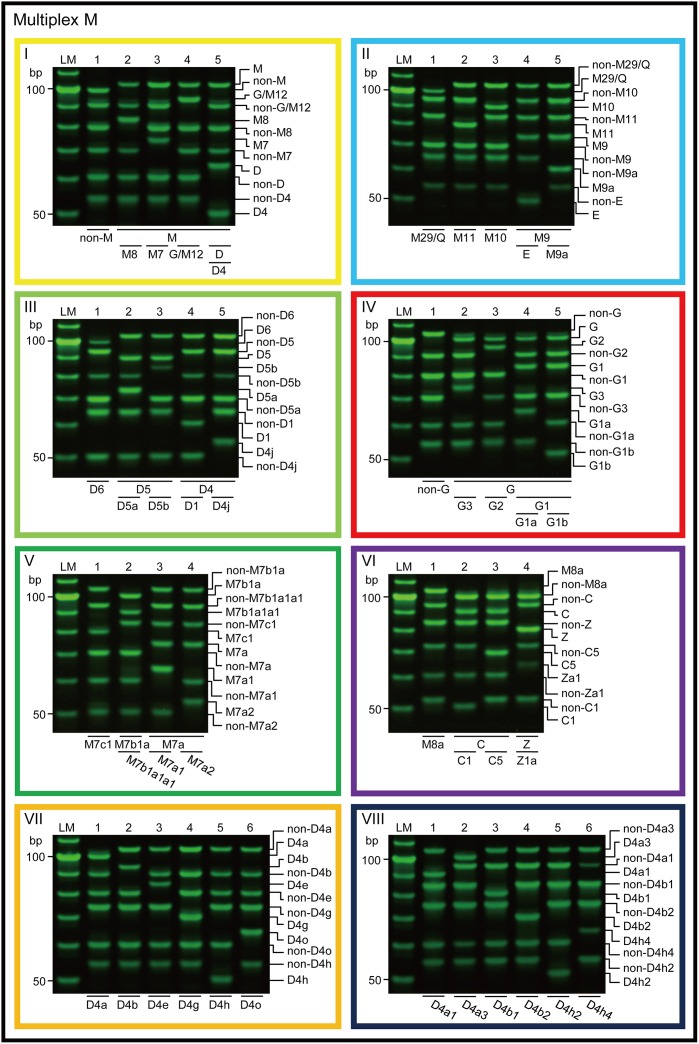
Electrophoretogram of PCR products from multiplexes M-I to M-VIII.The primer sets of multiplexes M-I to M-VIII are shown in Table 2. Yellow, light blue, light green, red, green, purple, orange, and blue frames indicate multiplexes M-I, II, III, IV, V, VI, VII, and VIII, respectively. This color coding corresponds to that given in Fig 2. LM indicates the 10-bp ladder marker.